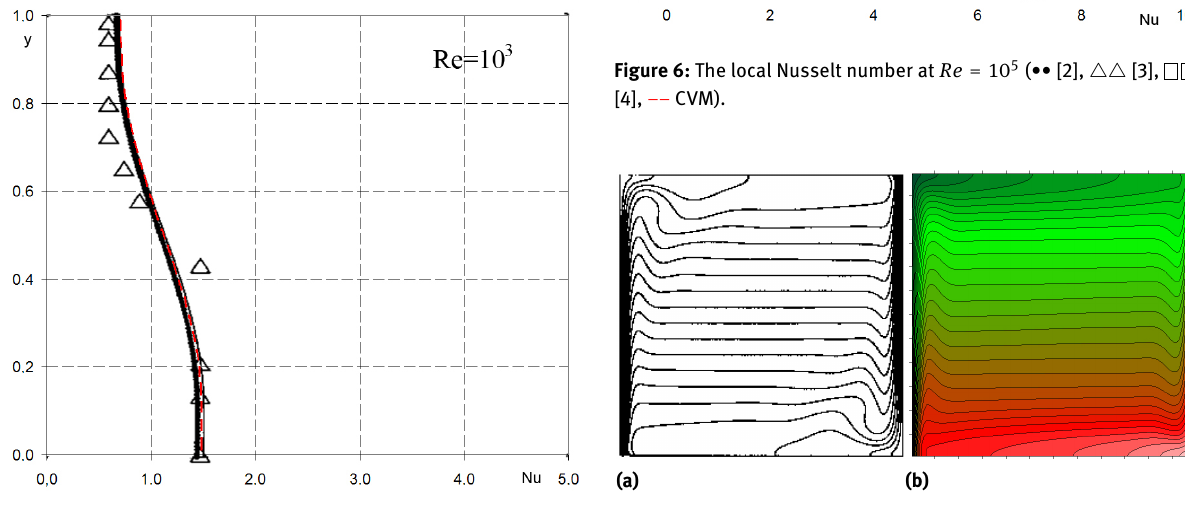
Figure 4: The local Nusselt number at Re = 10 3 ( •• [2], △△ [3], [4], −− CVM).